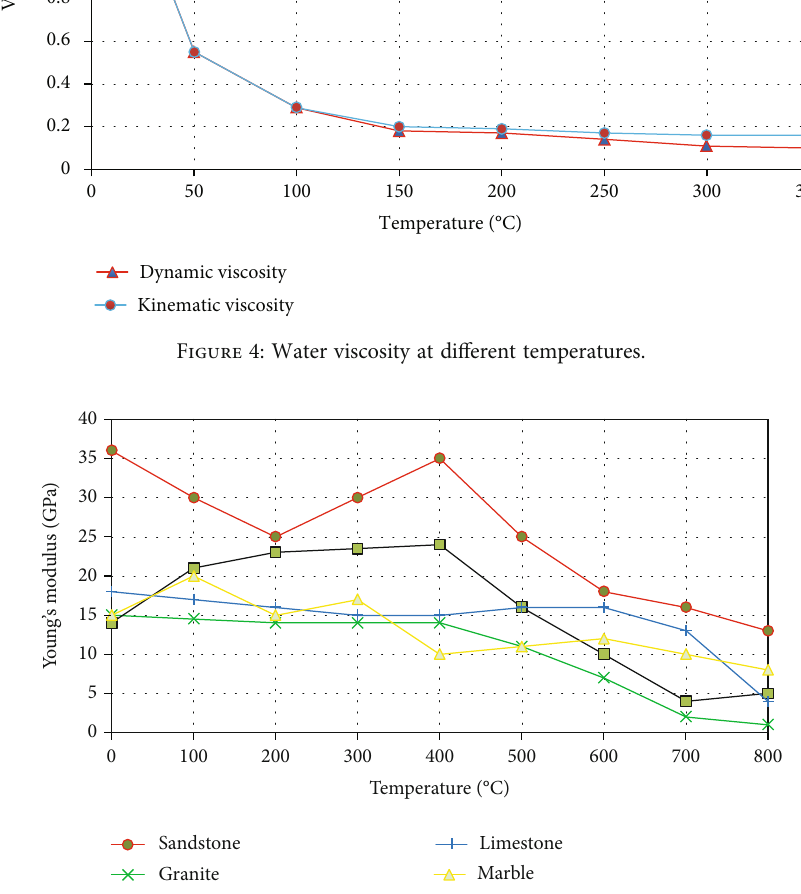
Figure 5: Young ’ s modulus of di ff erent rocks at various